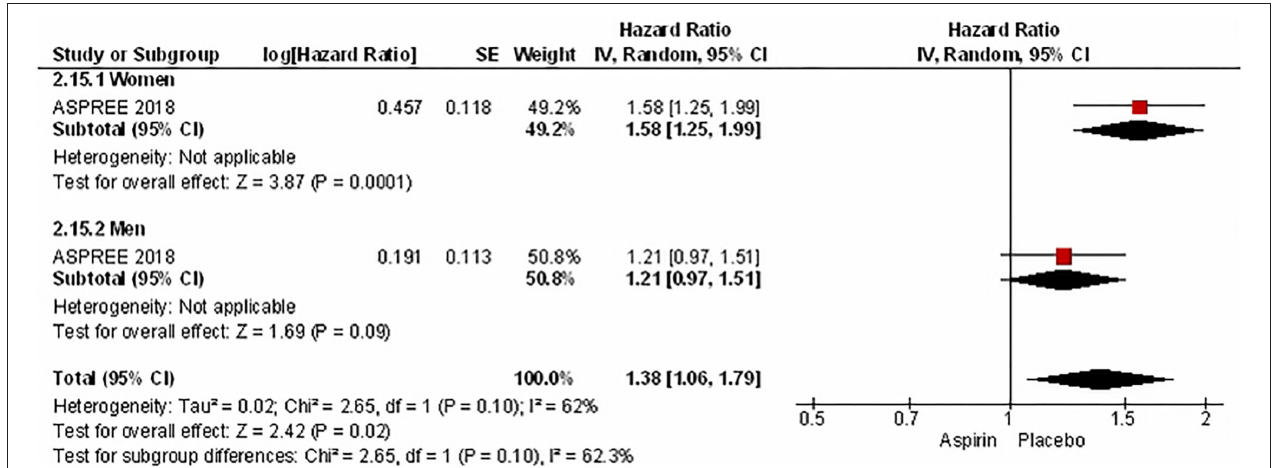
FIGURE 12 | Hazard ratio of major bleeding in women and men taking aspirin.